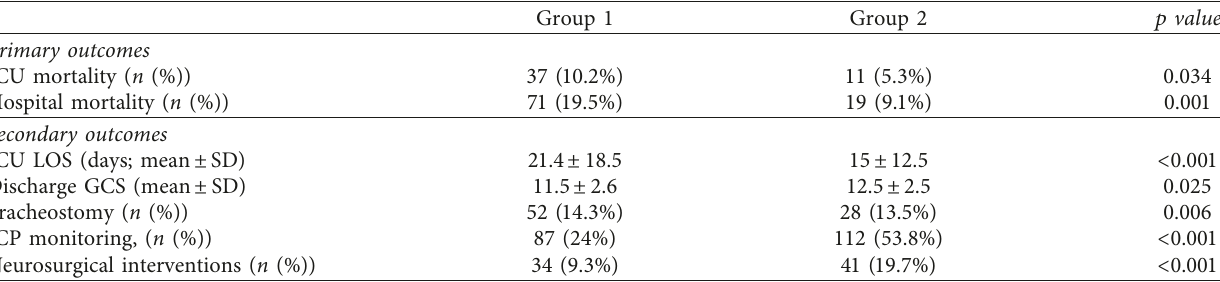
Table 2: Primary and secondary